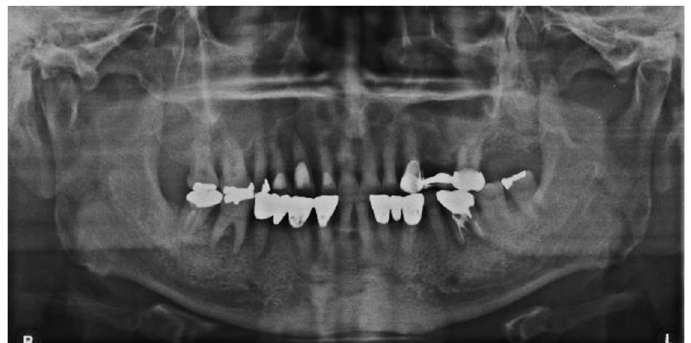
Figure 2. Panoramic radiography: no abnormal findings related to the chief complaint were noted.